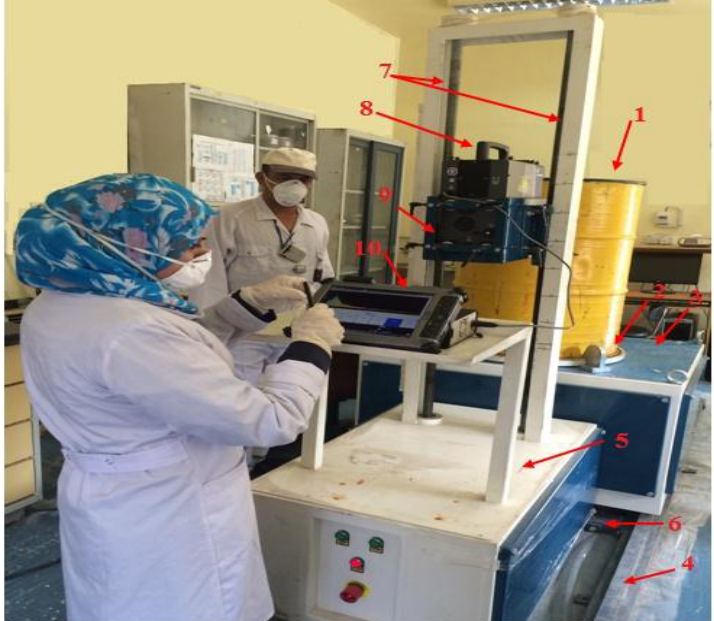
Fig.2 The local designed scanning